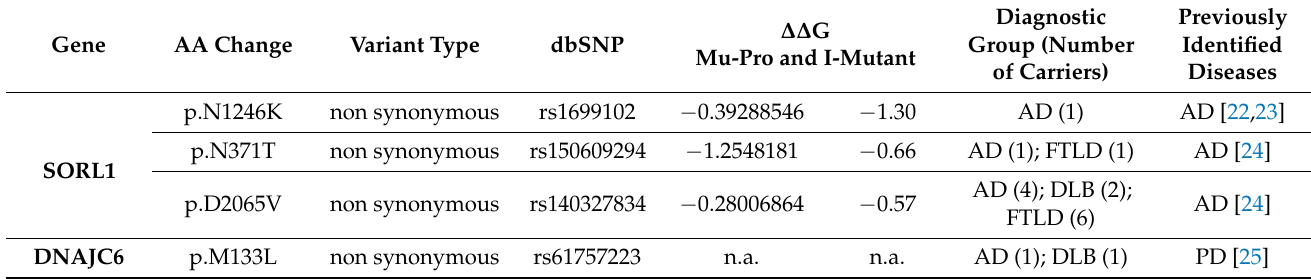
Table 2. List of previously reported disease-associated variants identified in AD, DLB and